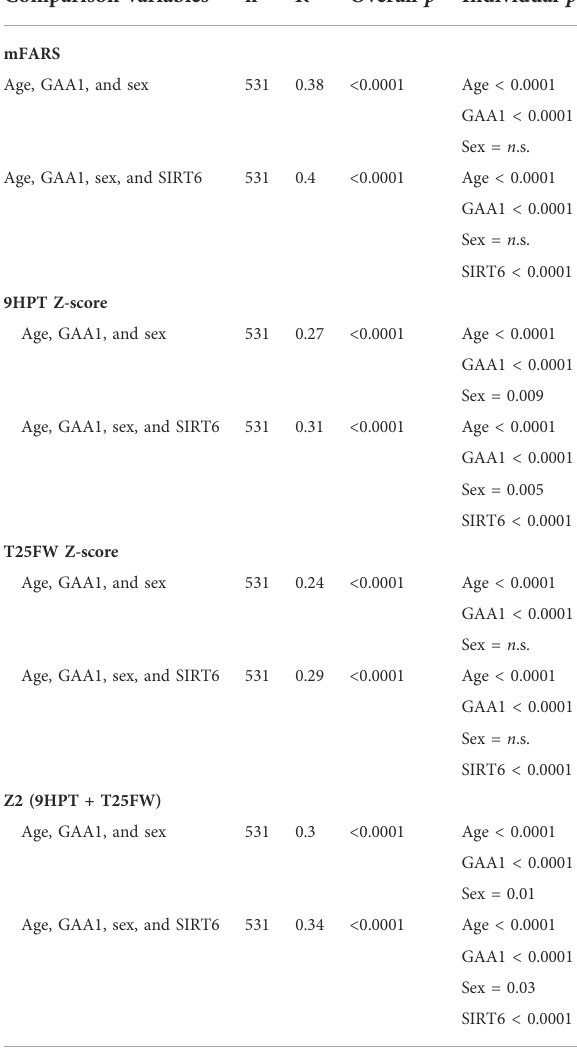
TABLE 3 SIRT6 genotype signi fi cantly improves predictions of clinical outcomes measures in FRDA. Column “ comparison variables ” lists independent variables used in multivariable comparisons. Overall, R 2 and p values as well as p values for each individual variable in the statistical model are shown. mFARS = modi fi ed Friedreich ataxia rating scale, 9HPT Z-score = 9-hole peg test Z-score, T25FW Z-score=timed25-footwalk Z-score.Zscoreswerecalculated as follows: (value - mean)/standard deviation. Z2 is the sum of the Z scores for 9HPT and T25FW.